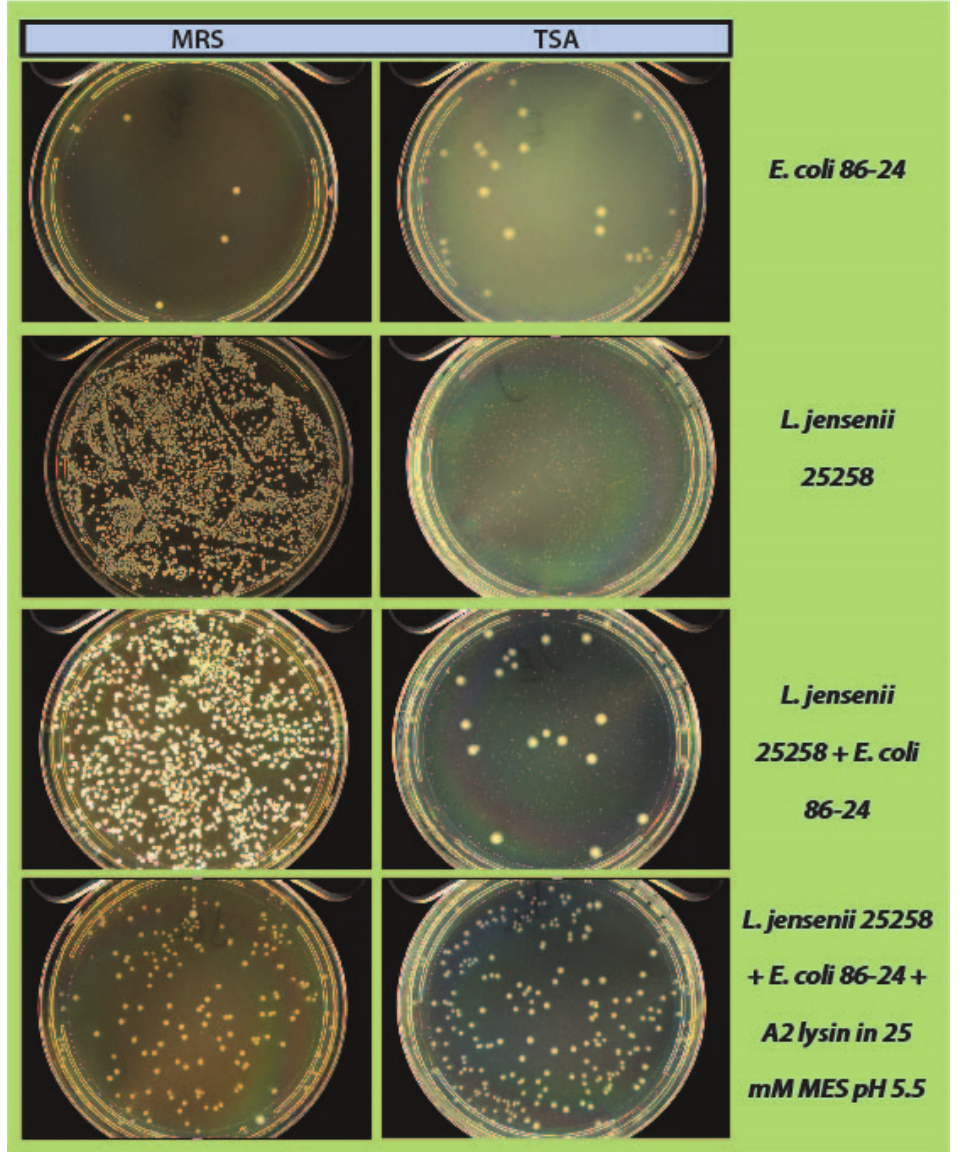
Figure 5. Mock purity assay, using L. jensenii as a mock product strain, and spiked with E. coli as a contaminant. High density L. jensenii cells were spiked with low numbers of E. coli . Samples incubated with LysA2 showed no L. jensenii growth, allowing for the clear recovery and detection of contaminating E. coli colonies.